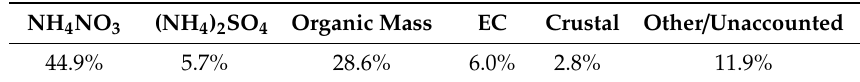
Table 3. Average percent of each major component of PM 2.5 , Fresno IMPROVE monitoring site in the period of 2004–2018.